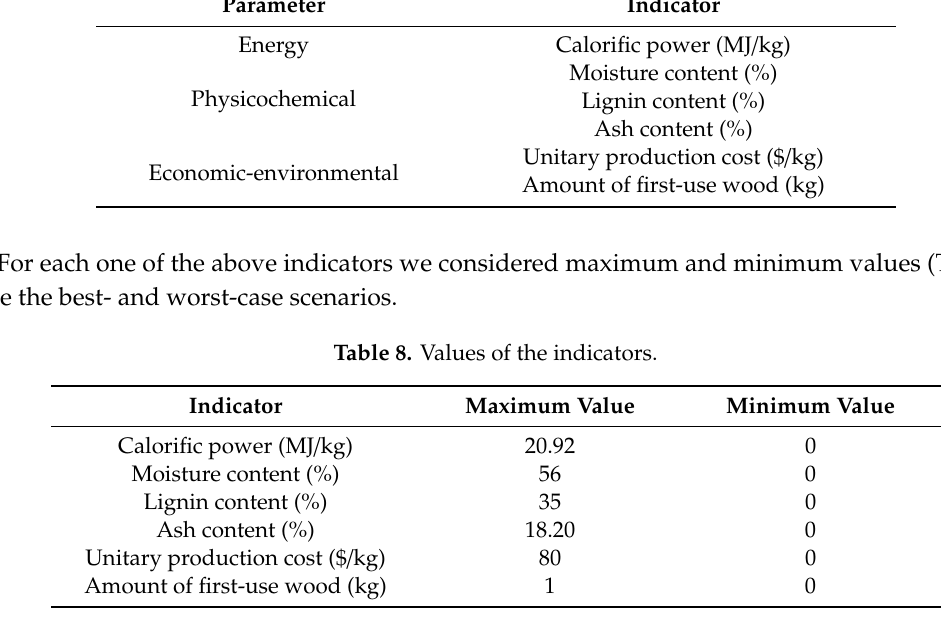
Elaborating Table 8 entailed considering the following: